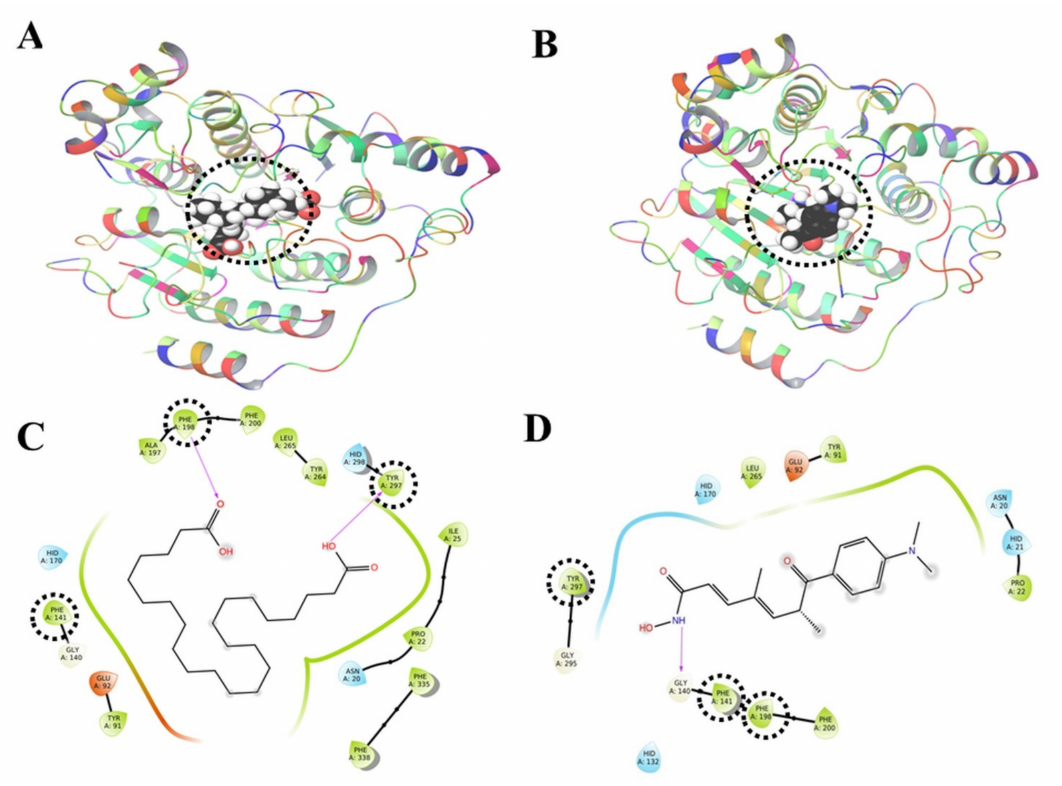
Figure 7. Tetracosanedioic acid, an intracellular long-chain FFA detected in CUDF-treated MCF- 7 cells, displays strong molecular interactions at the inhibitory site of HDAC. ( A ) Protein–ligand complex with grey ribbon structure with a full 3D view between HDAC homolog complex with pink color and a biolistic model of tetracosanedioic acid. ( B ) Protein–ligand complex with grey ribbon structure with a full 3D view between HDAC homolog complex with pink color and a biolistic model of trichostatin A. ( C ) Visualizer software-assisted 2D image of the binding mode of tetracosanedioic acid (PubChem CID 2724554) and HDAC homolog complex (1C3R) at the inhibitory site of amino